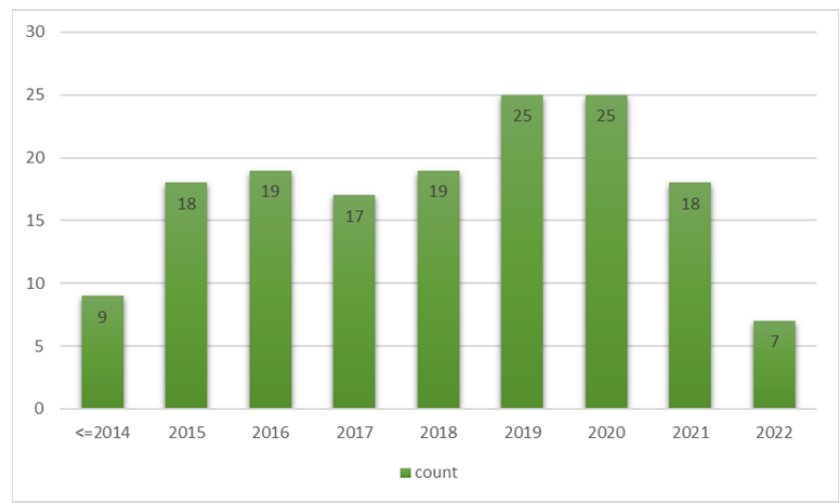
Figure 5 . Year of published papers . Figure 5. Year of published papers.